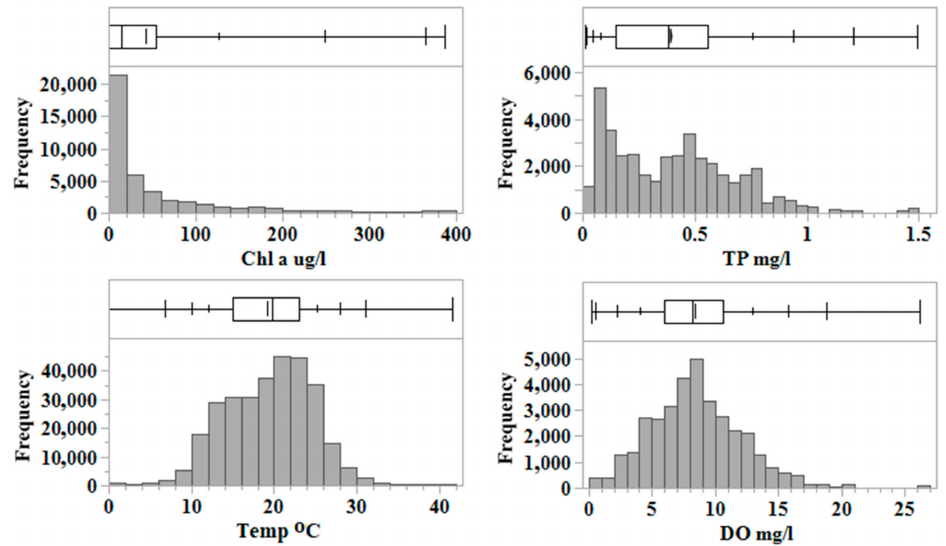
Figure 2. Distribution plot of various water quality parameters in the Hartbeespoort Dam;